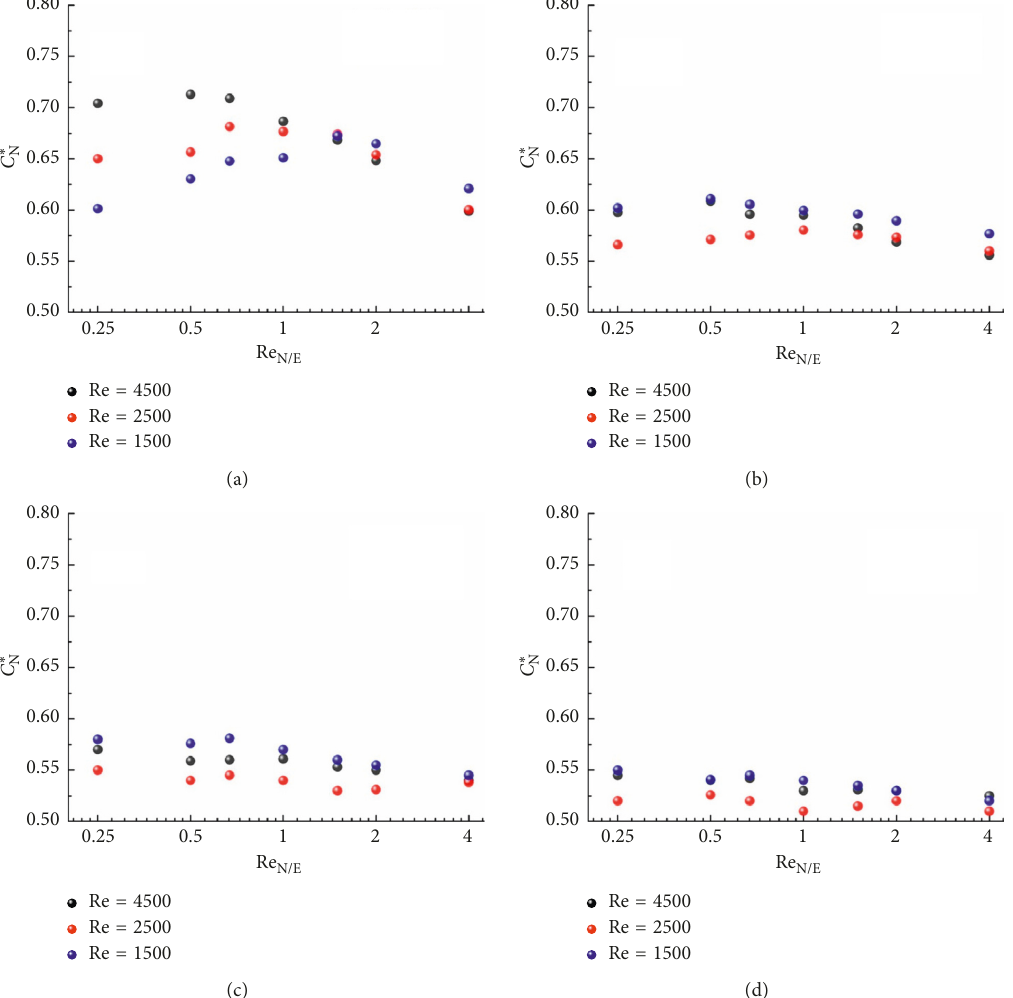
Figure 9: Dimensionless concentration C ∗ (b) L / D � 5.0; (c) L / D � 7.5; (d) L / D � 10.0.